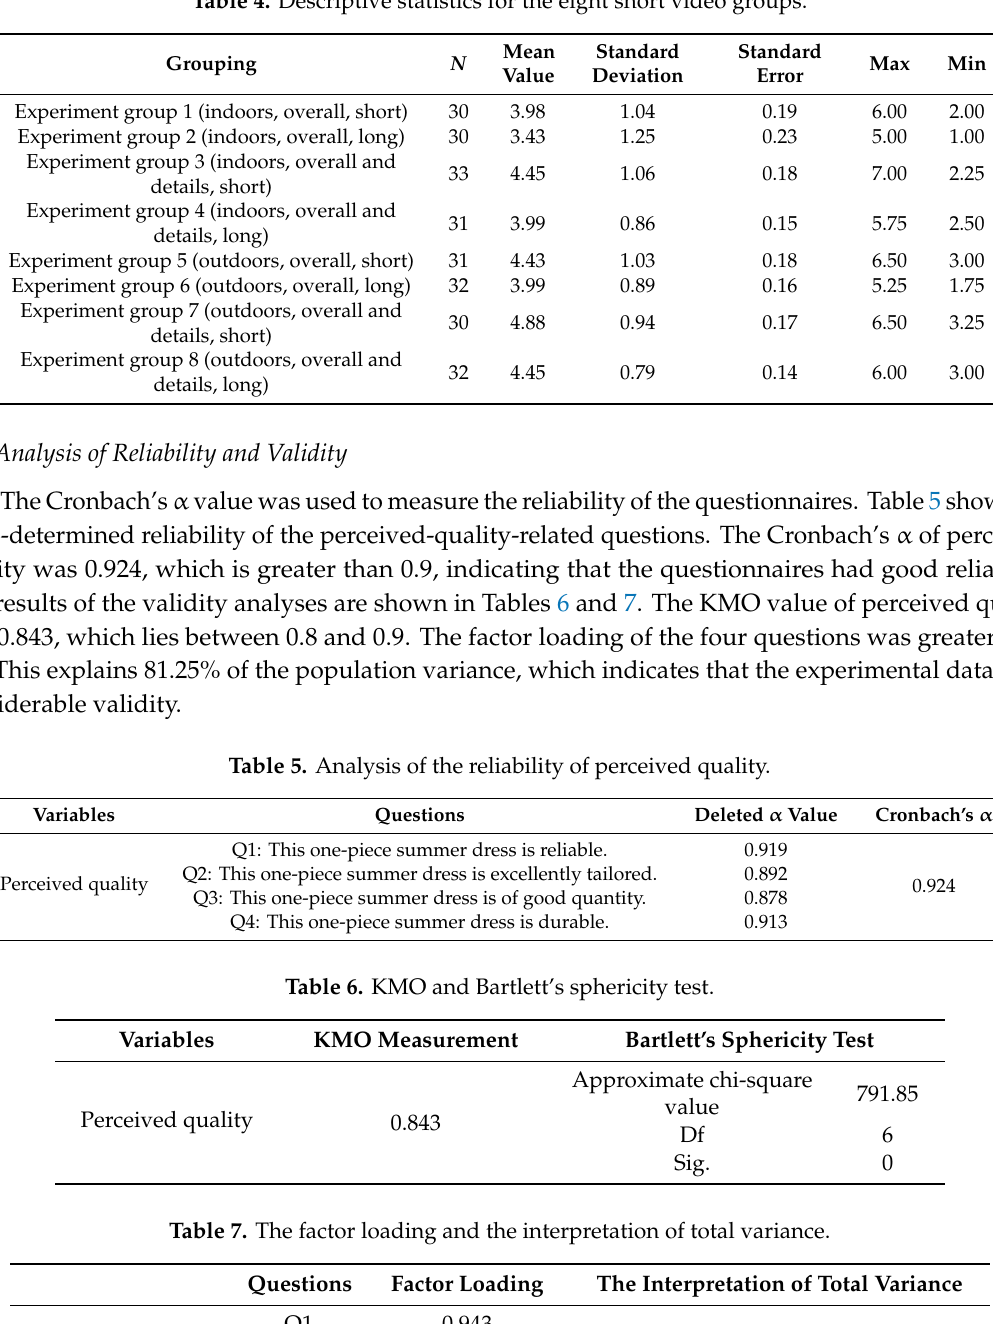
Table 4. Descriptive statistics for the eight short video groups.